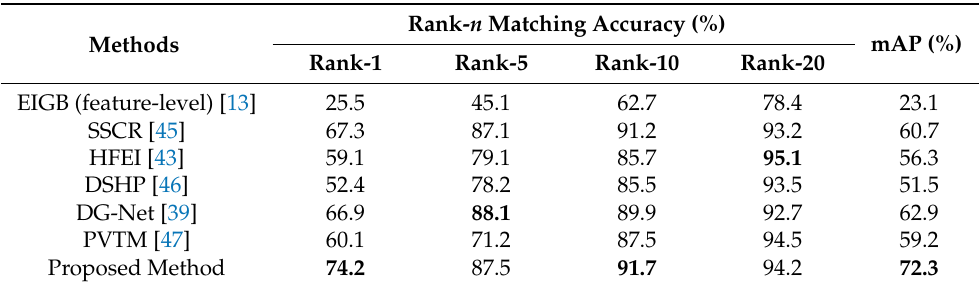
Table 5. Comparison with the state-of-the-art methods on the CASIA Gait Database B. Rank-n matching accuracy (%) and mAP (%) are